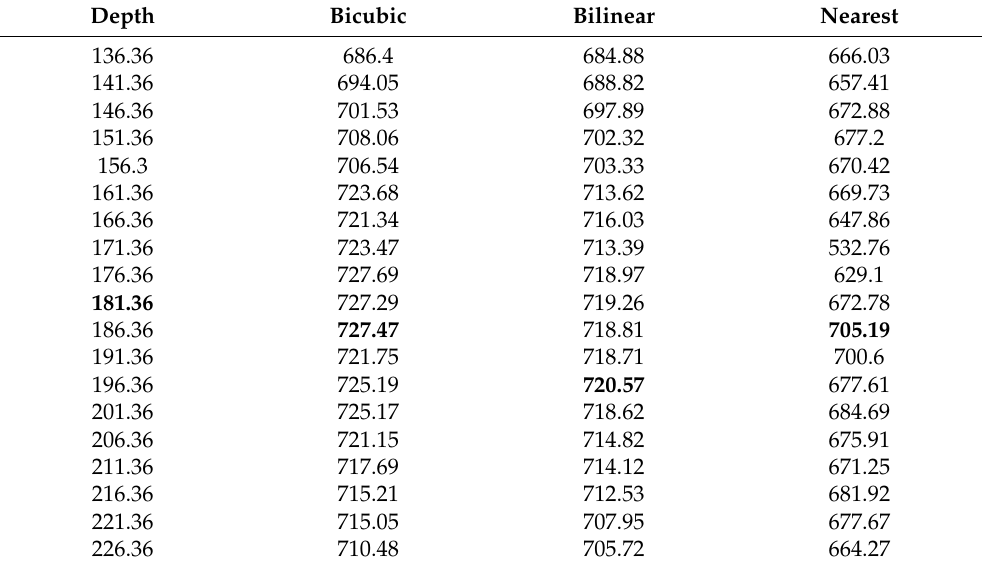
Table 2. PSR values of simulation results via various reconstruction depths by digital zooming with interpolation methods such as nearest, bilinear, and bicubic. Magnification ratio is 8.8. Depth Bicubic Bilinear